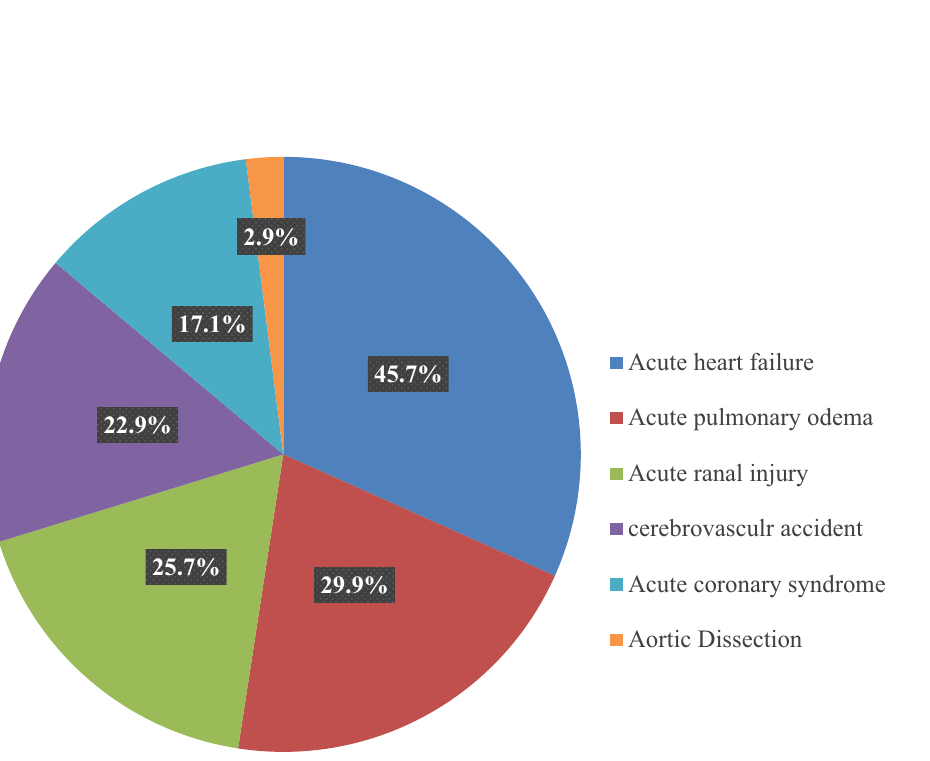
Figure 3. Pattern of target organ damages of patients with hypertensive